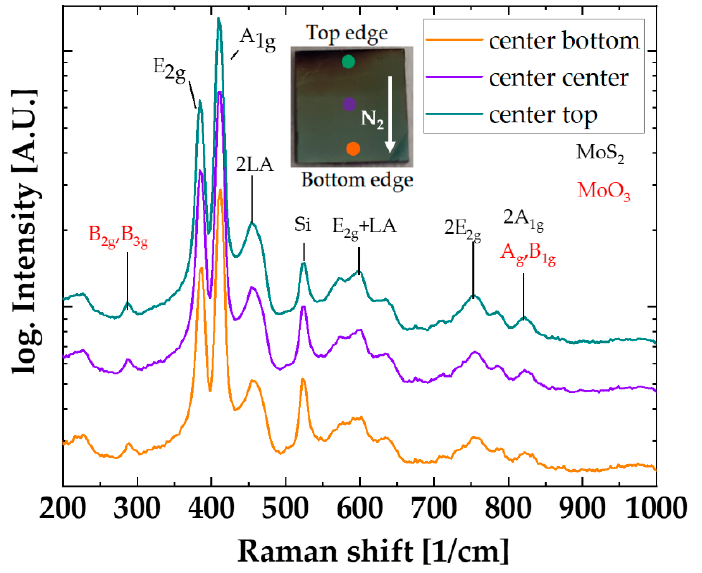
Figure 2. Raman spectra obtained from different points on the 3D MoS 2 nanosheet. Inset shows a photograph of the 1 × 1 cm growth substrate with Raman measurement points and the N 2 flow direction (arrow mark points to the outlet).